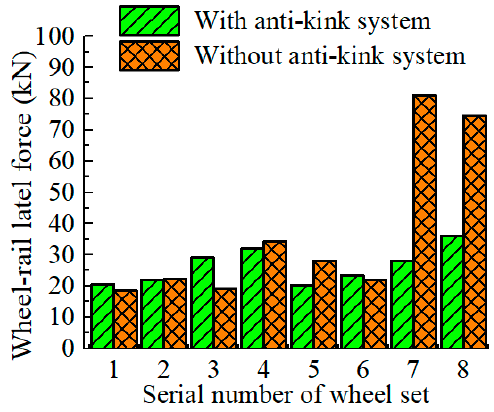
Figure 12. Wheel–rail lateral force.